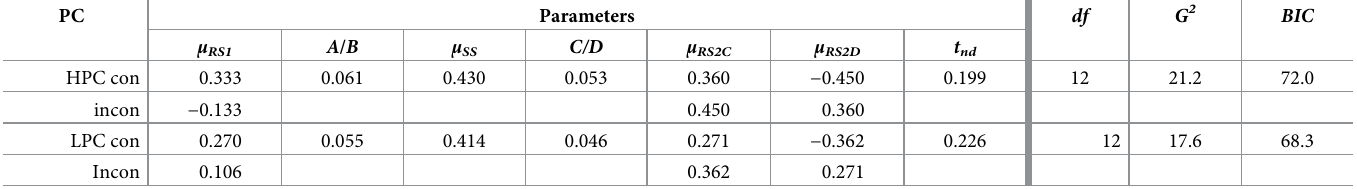
The values that differ for the incongruent condition, compared to the congruent (“con”) one, are given in the rows labeled as